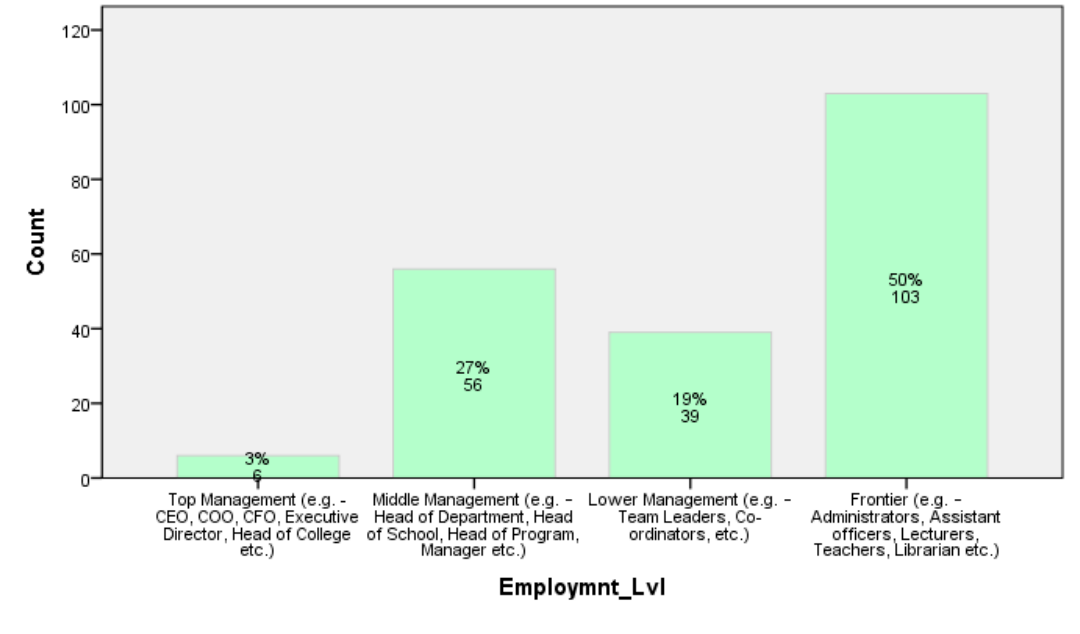
Figure 4. Employment Level Distribution.